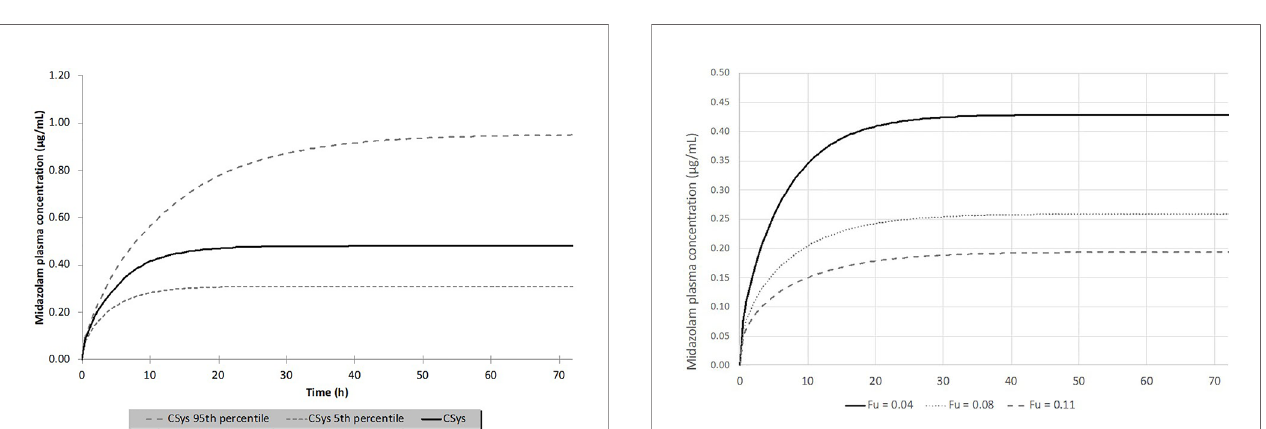
FIGURE 4 | Median ( ± 90% CI) predicted systemic concentrations (C sys ) of midazolam following intravenous infusion at 0.05 mg/h/kg in 19 normothermic neonates (mean body weight 3.91 ± 0.86 kg) for 72 h (total dose 3.6 mg/kg). The solid line and the dashed lines represent the median and 5/95% percentiles. The median concentration at steady state was 0.48 μg/ml.